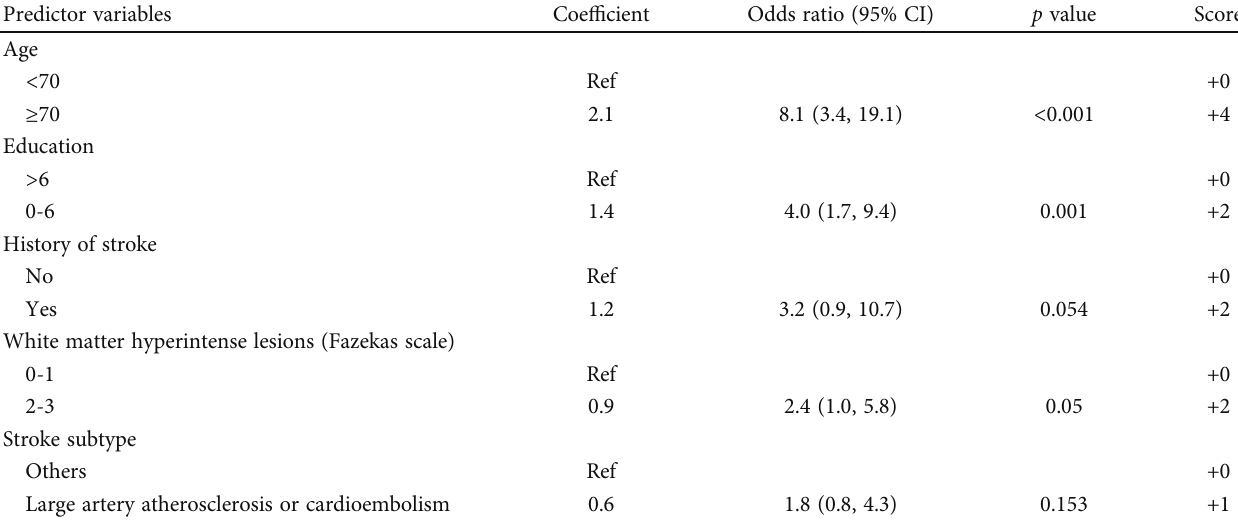
Table 2: Final multivariable logistic regression model with vascular dementia as the outcome